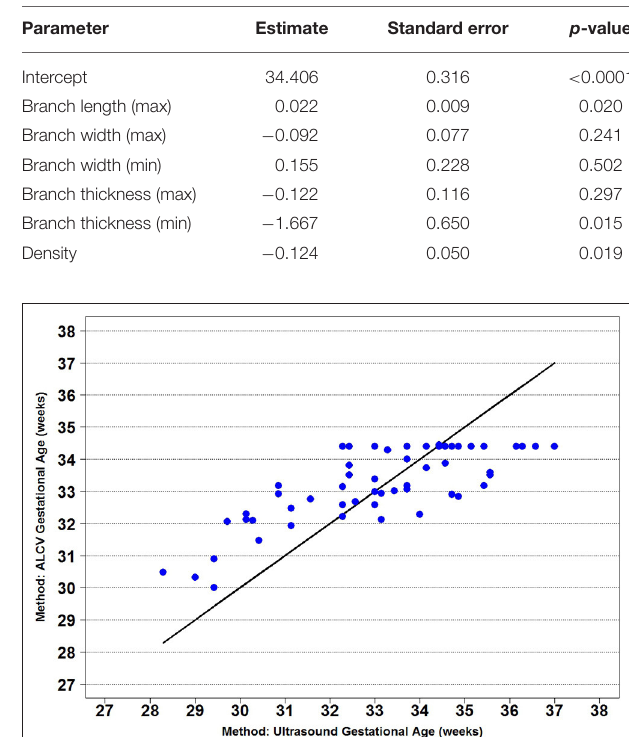
TABLE 1 | Final ALCV model parameters for prediction of gestational age ( n = 64).